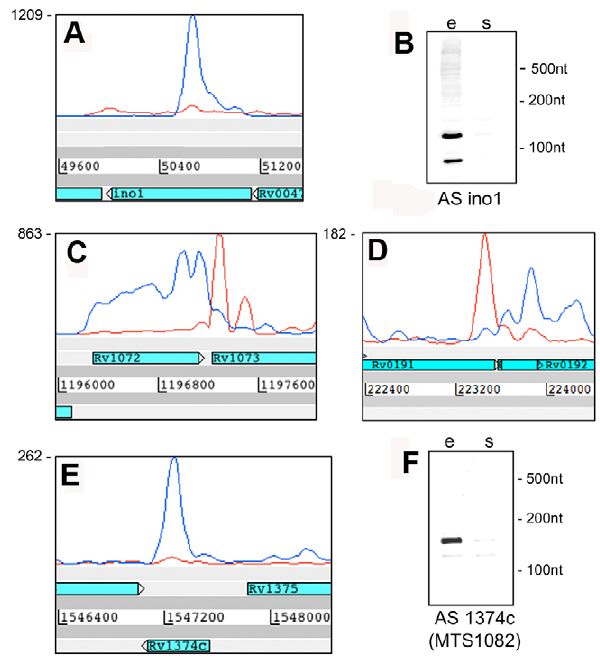
Figure 3. Antisense transcripts independent of 3’ UTRs. Artemis profiles are shown for antisense transcripts that cover the middle (A) or either end of a gene (C, D), or that cover the entire CDS (E). Panels B and F illustrate further characterization of the ino1 (Rv0046, inositol-1- phosphate synthase) and Rv1374c antisense transcripts by Northern blotting.